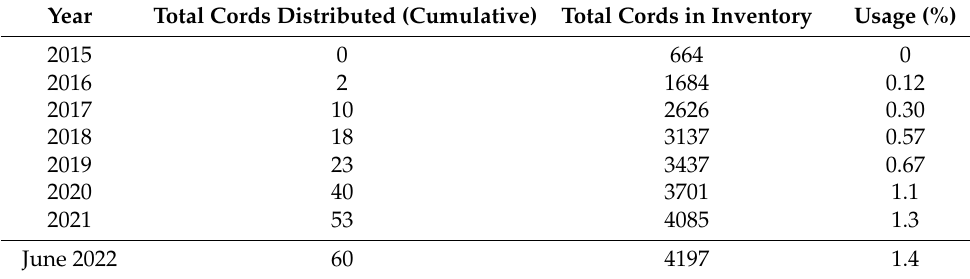
Table 1. Usage of the CBS’ Cord Blood Bank.